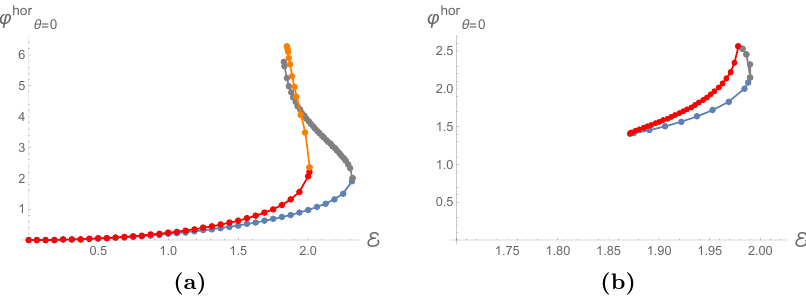
Figure 14. The value of the scalar (cid:12)eld at the horizon for T = 1 =(cid:25) and T = 0 : 24179, from left to